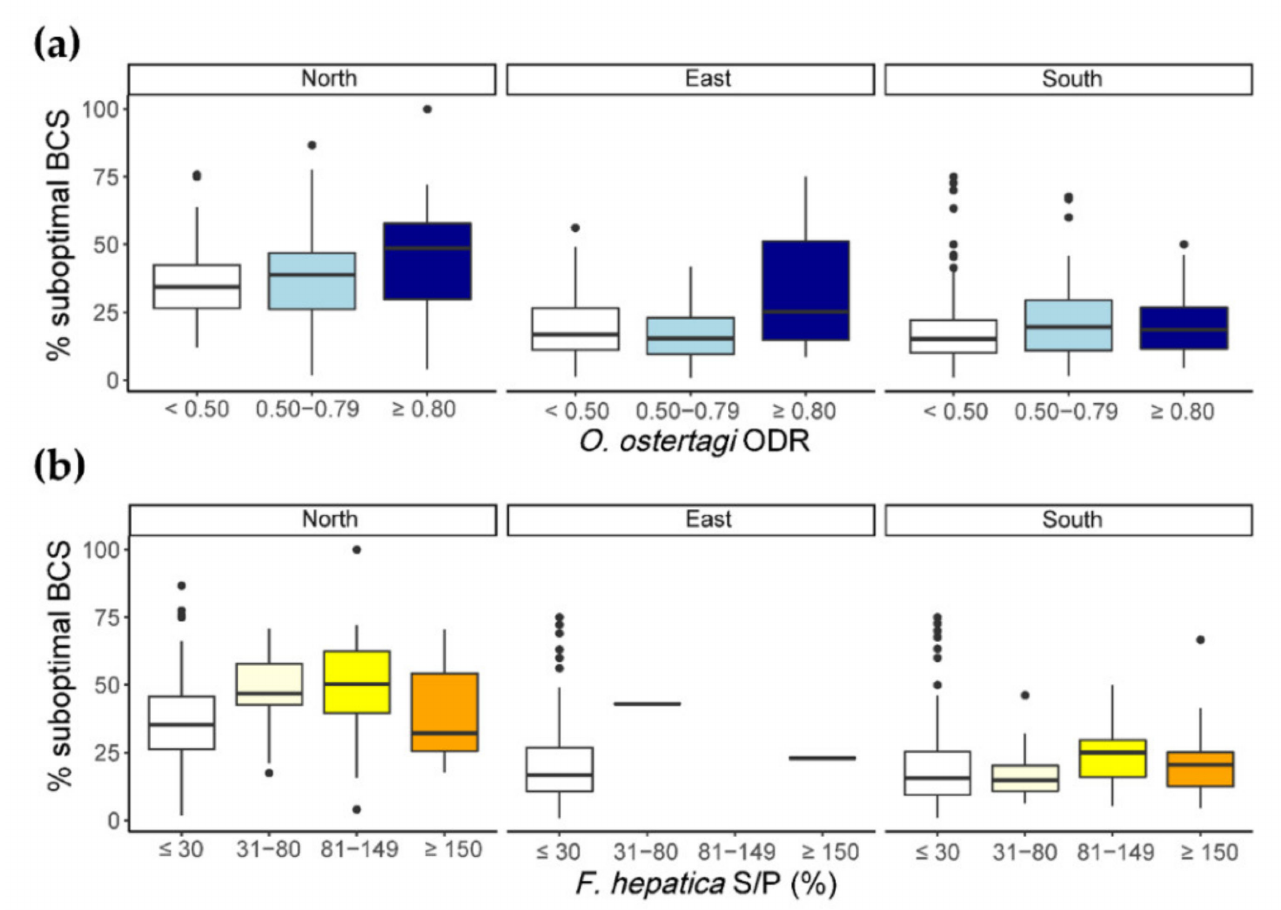
Figure 3. Percentage of cows with a suboptimal body condition score (BCS) according to BTM antibody level categories for O. ostertagi ( a ) and F. hepatica ( b